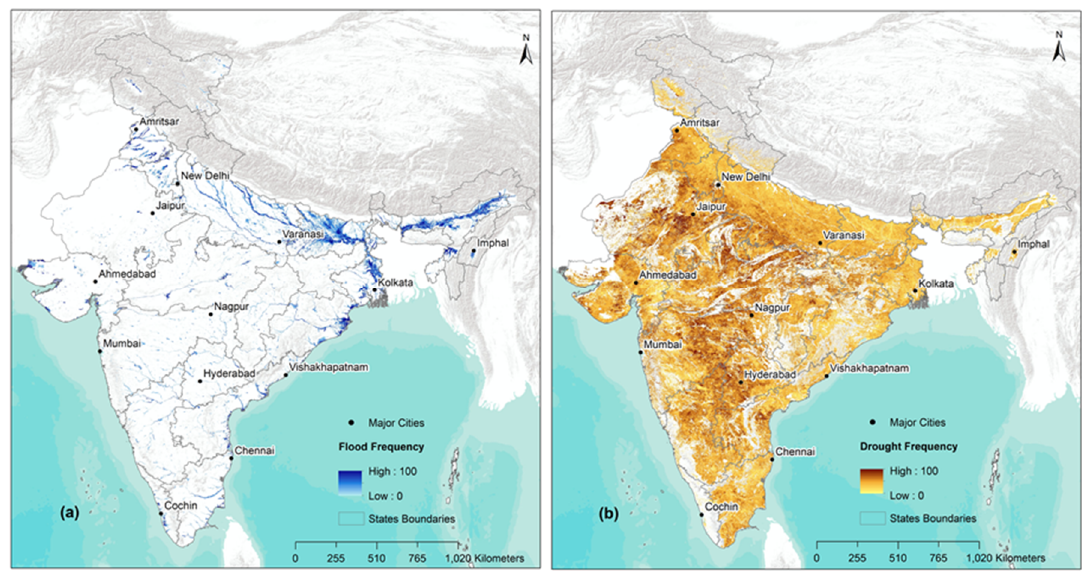
Figure 2. Maximum exposed area to ( a ) floods and ( b ) droughts using combined hazard and population gridded data.